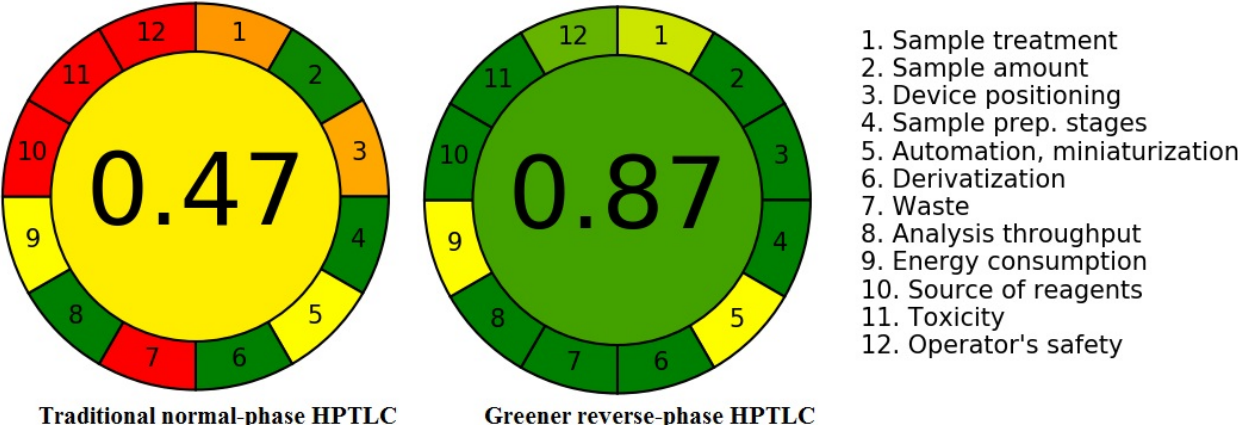
Figure 4. The pictograms of the AGREE indices for the traditional and the greener HPTLC strategies recorded utilizing the “AGREE: The Analytical Greenness Calculator”.